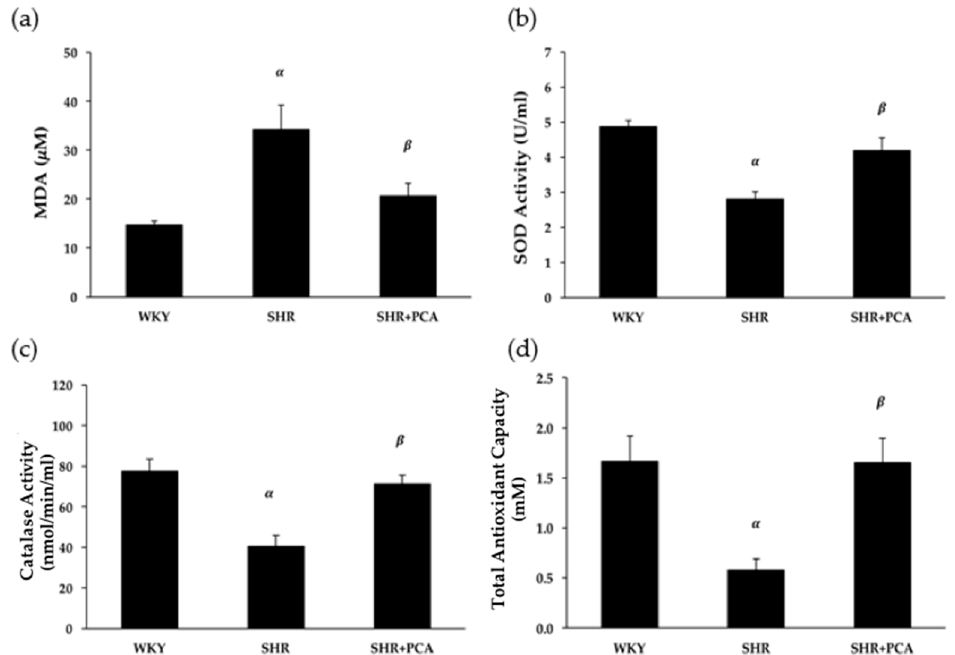
Figure 6. ( a ) Serum malondialdehyde (MDA) concentration, ( b ) superoxide dismutase (SOD) activity, ( c ) catalase activity, and ( d ) total antioxidant capacity among the WKY, SHR, and SHR+PCA groups. α , p < 0.05, significant differences from WKY; β , p < 0.05, significant differences from SHR; n = 8 in each group.